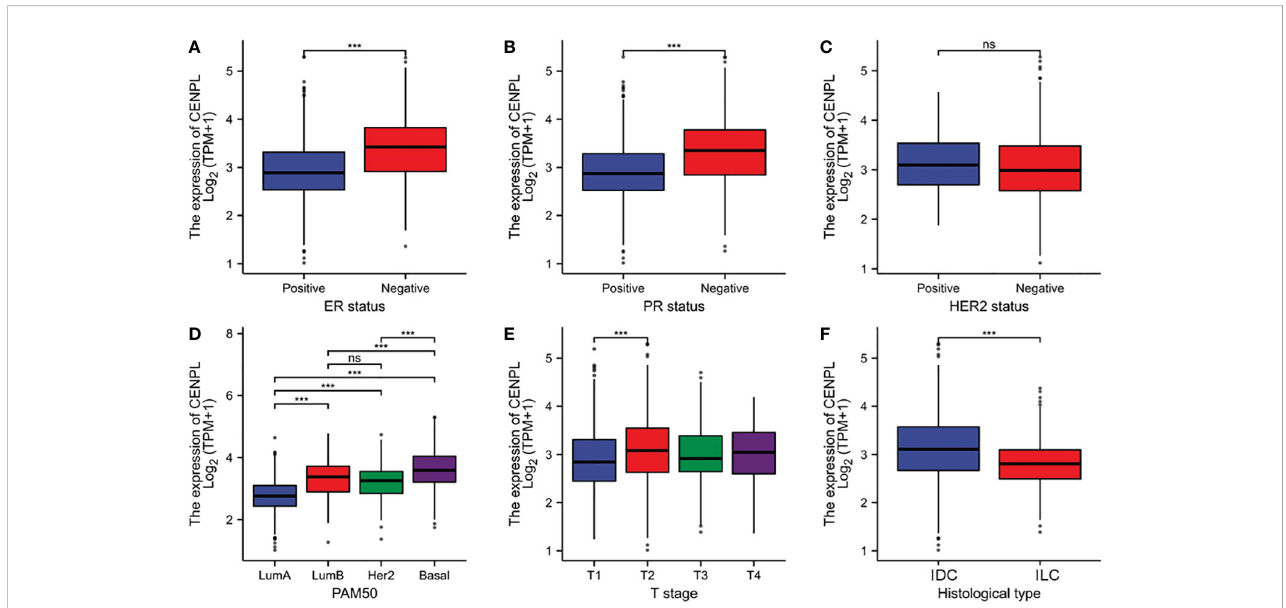
FIGURE 3 Relationship between CENPL expression and clinicopathologic features of breast cancer patients. (A) ER status based on CENPL expression level. (B) PR status based on CENPL expression level. (C) Her-2 status based on CENPL expression level. (D) Pathological type based on CENPL expression level. (E) T stage based on CENPL expression level. (F) histological type based on CENPL expression